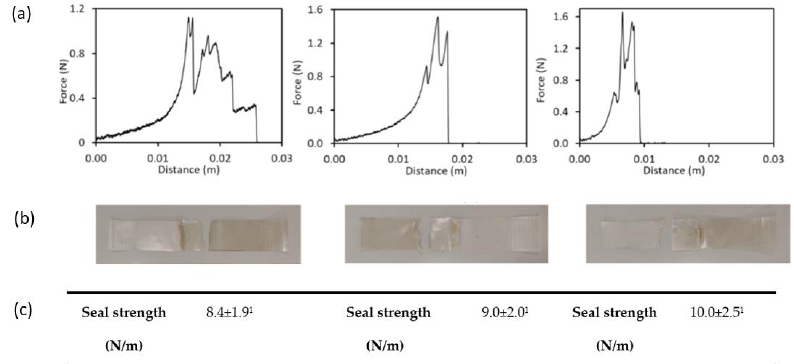
Figure 2. Typical behavior of seal profile of the starch-polyester bilayer films at different storage times (t0, t1, and t2). ( a ) Force-distance curves. ( b ) Image of the sheet separation mode: delamination and ( c ) mean values and standard deviation of seal strength (N/m). Different superscript numbers indicate significant differences between the seal strength values at the three storage times ( p < 0.05).